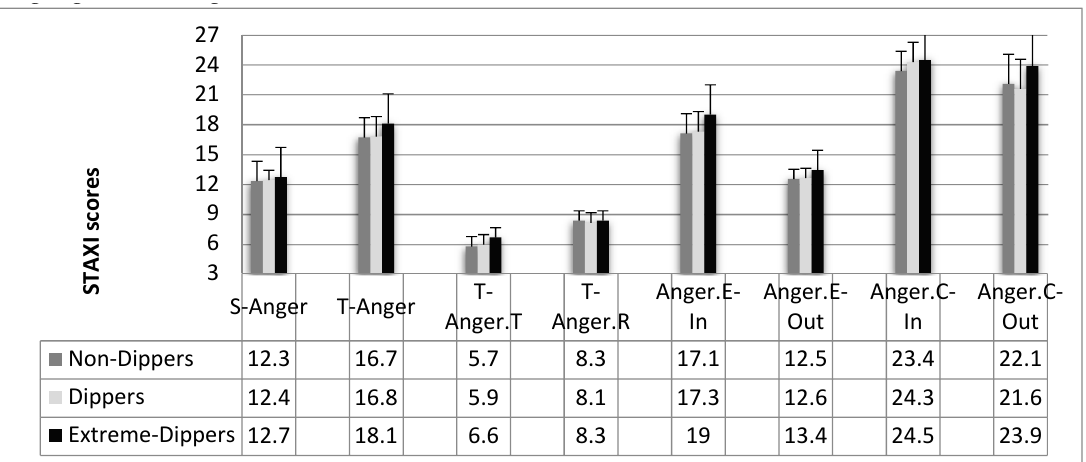
Figure 1. Mean scores and standard errors of the STAXI scales for the three groups of participants. Table 4. Means of anger scores and χ 2 results for Non-Dippers, Dippers, and Extreme Dippers in the three groups of Normotensive, Untreated, and Treated Hypertensive